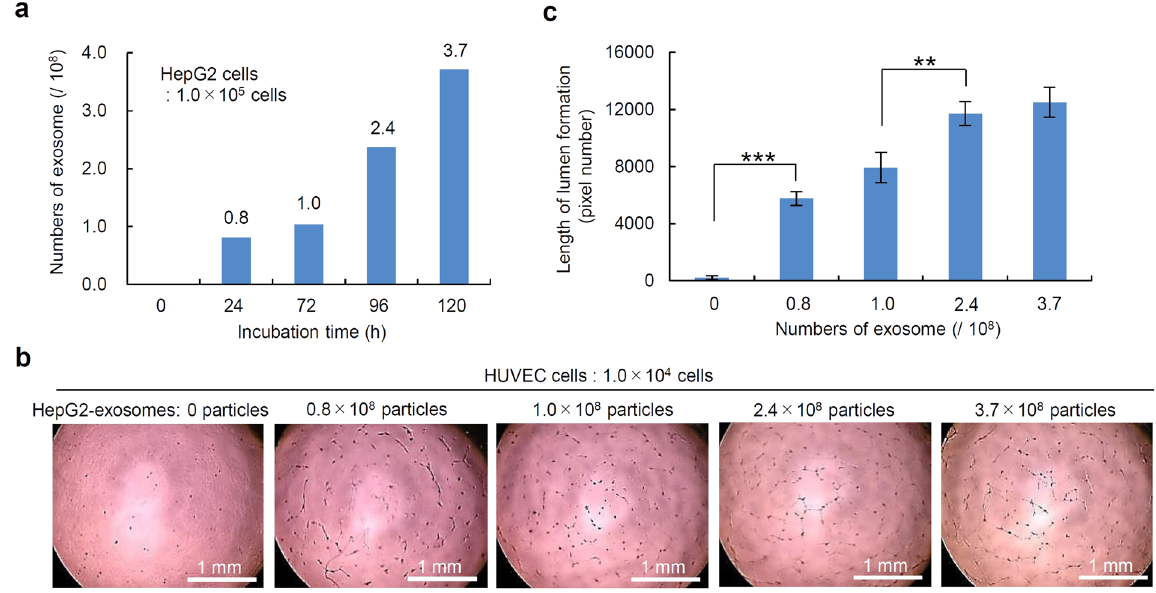
Figure 4. The influence of the length of incubation of HepG2 cells on the production of exosomes and the lumen formation by HUVECs. ( a ) The number of exosomes secreted from HepG2 cells (1 × 10 5 cells) incubated for different lengths of time (0, 24, 72, 96 and 120 h) at 37 °C. ( b ) The lumen formation by HUVECs in the presence of exosomes secreted from HepG2 cells (1 × 10 5 cells) incubated for different numbers of HepG2- exosomes. ( c ) The length of the lumen structures of HUVECs formed in the presence of exosomes secreted from HepG2 (1 × 10 5 cells) incubated for different numbers of HepG2-exosomes. These data are shown as the